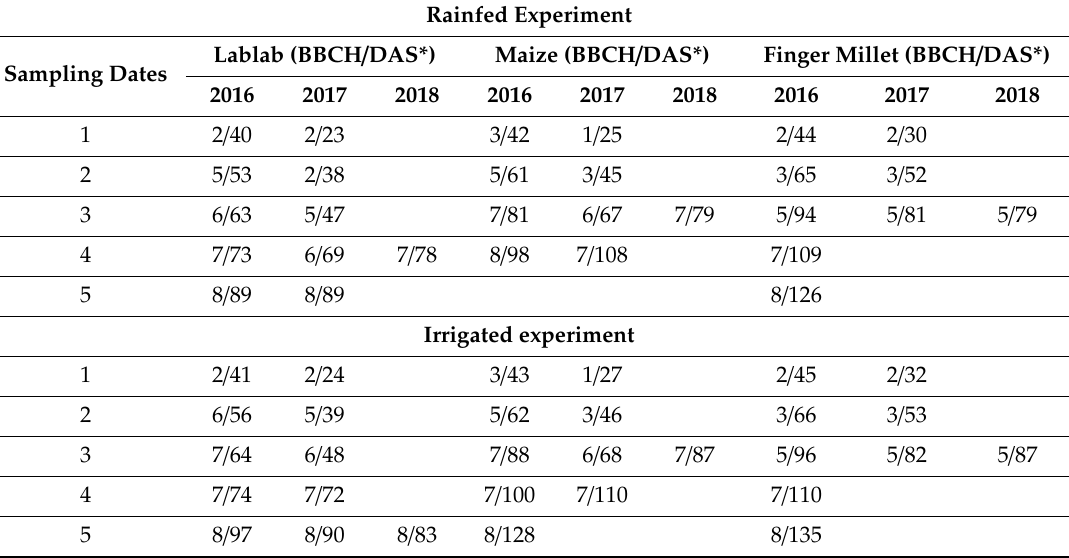
Table A3. Phenological stages of lablab, maize and finger millet at the sampling dates in rainfed and irrigated experiment from 2016 to 2018 (BBCH